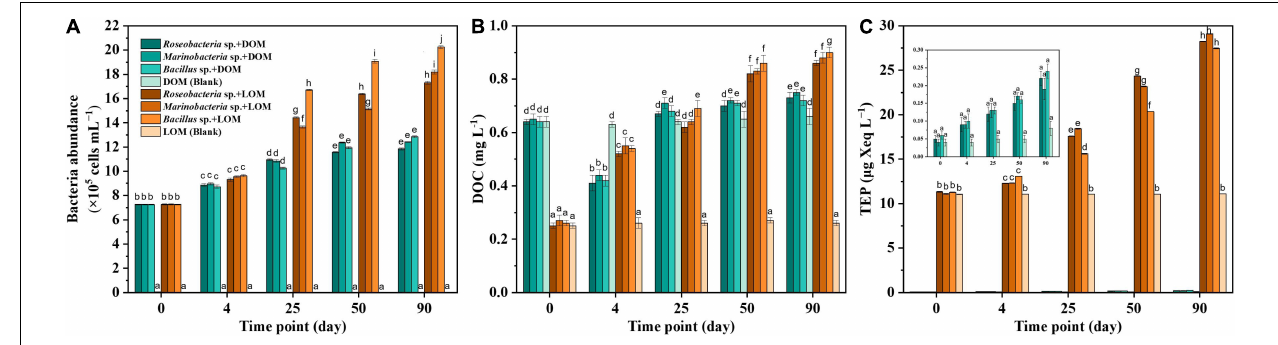
FIGURE 1 | Bacteria abundance (A) , DOC (dissolved organic carbon, B ) and TEP (transparent exopolymer particles, C ) for the different treatment groups and associated blanks. Error bars represent the standard error for triplicates cultures. Comparison between all DOM and LOM treatments for all experimental days. Different lowercase letters represented significant difference ( p < 0.05).